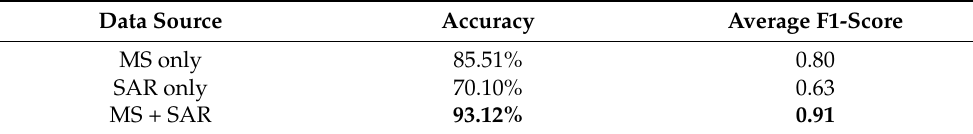
Table 1. Overall accuracy and average F1-score for different data sources in test set.